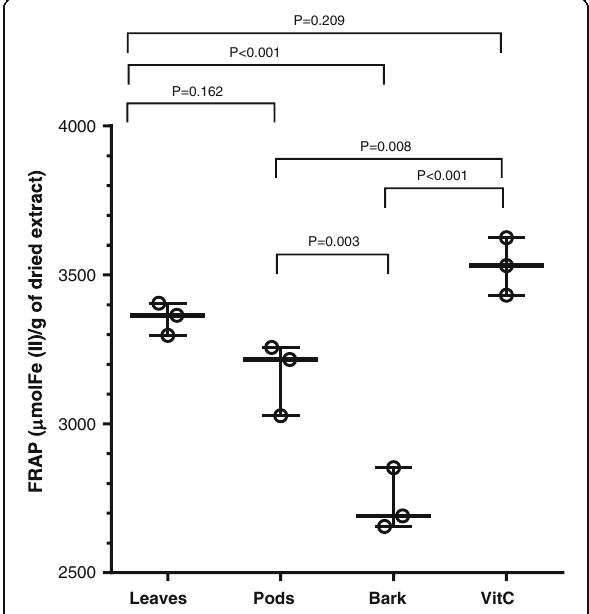
Fig. 3 Ferric reducing antioxidant potential (FRAP) of